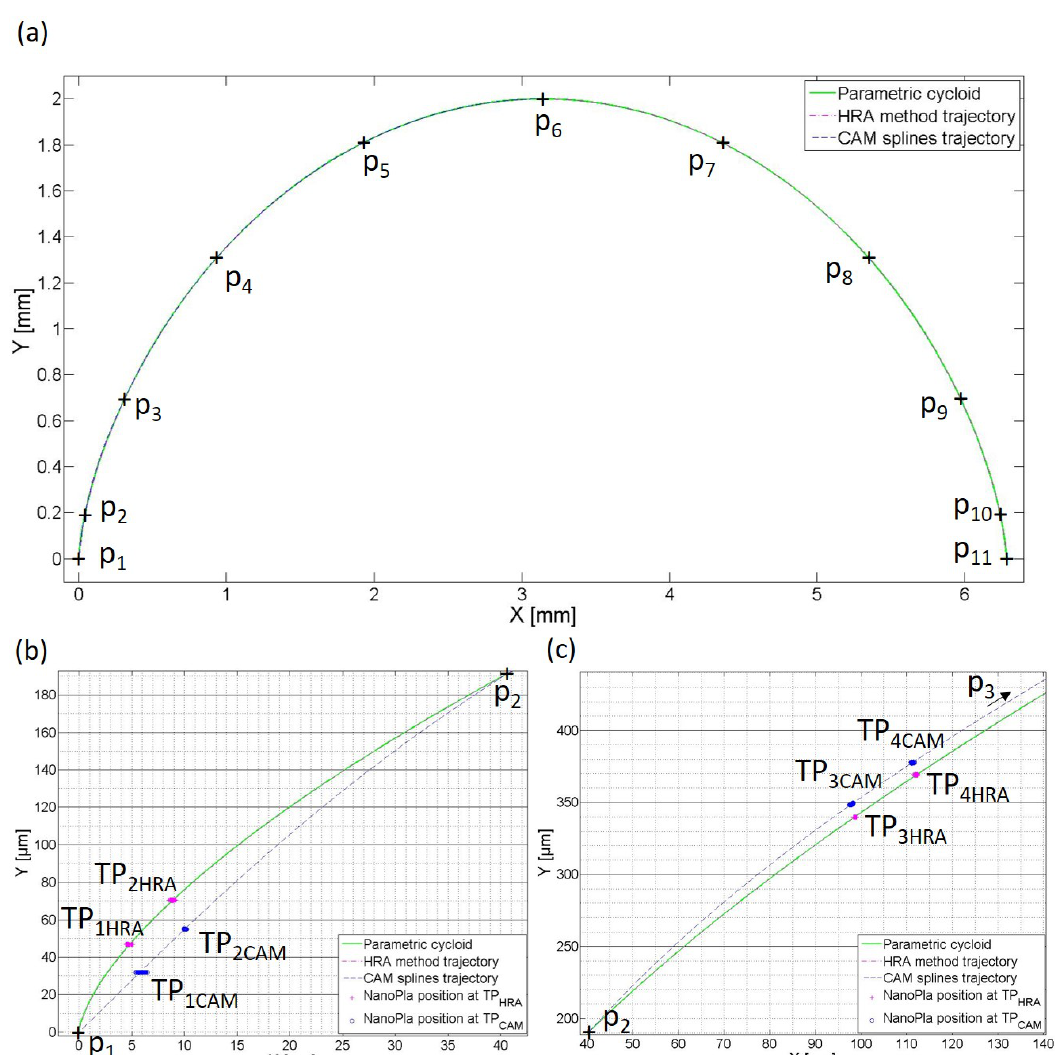
Figure 8. ( a ) Trajectories defined by interpolating the data points p 1 , . . . , p 11 with the HRA method and CAM splines; detail of the first non-data interval ( b ) and the second non-data interval ( c ), including the position of the NanoPla at certain trajectory